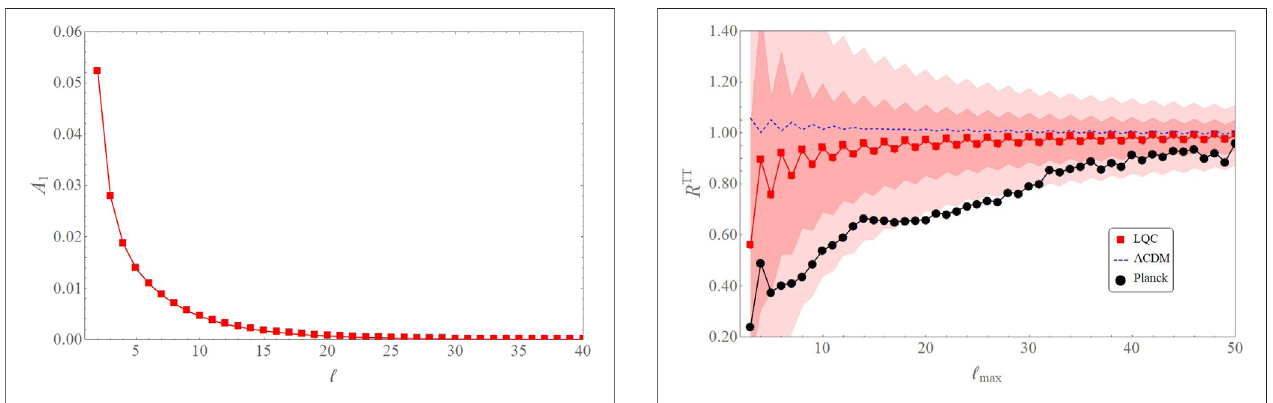
FIGURE 8 | R TT ( ℓ max ) for the modulated spectrum generated in LQC (solid red). R TT ( ℓ max ) predicted in LQC shows a preference for odd parity for low multipoles, unlike the one in the standard model (dashed, blue).